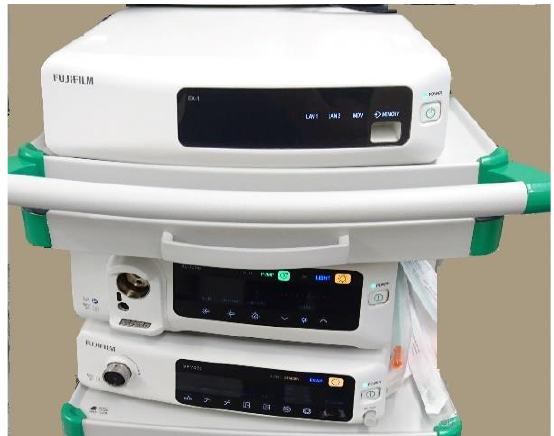
Figure 5. Fujifilm endoscopy system with EX1 CADEYE AI platform on top.